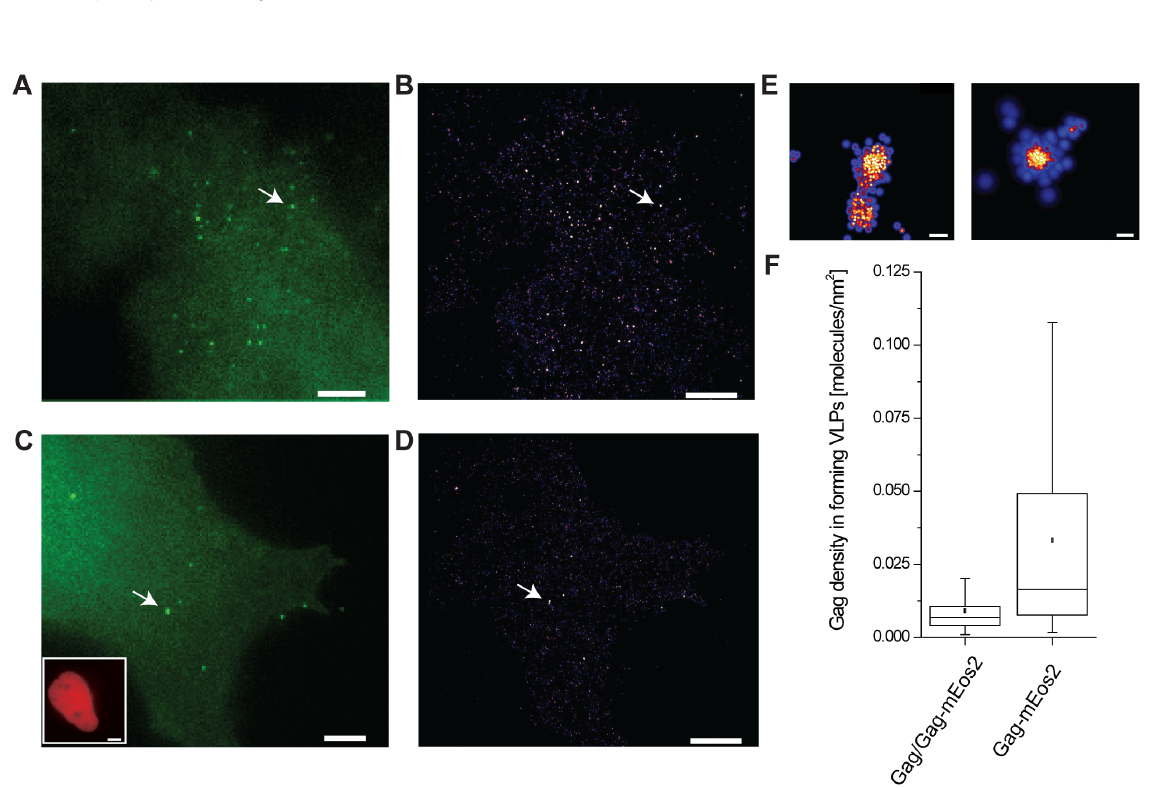
Figure 5. Unlabeled and labeled Gag protein incorporation into forming VLPs. ( A ) Diffraction limited image and ( B ) corresponding super-resolution image of a Cos7 cell expressing Gag-mEos2 only. ( C ) Diffraction limited image and ( D ) corresponding super-resolution image of a Cos7 cell co-expressing Gag and Gag-mEos2, co-transfected at an equimolar ratio. The presence of Gag is indicated via the fluorescent reporter protein H2B-mPlum (lower left inset). Scale bars, 5 m m. ( E ) Left, zoom of indicated VLP in (B). Right, zoom of indicated VLP in (D). Scale bars, 100 nm. ( F ) Gag density in forming VLPs as determined from PALM images and molecular counting. Closed squares indicate the mean, horizontal lines within the boxes median, and boxes indicate 25 th and 75 th percentiles while vertical bars indicate 5 th and 95 th percentiles. Cells co-expressing unlabeled and labeled Gag display lower densities, indicating the presence of unlabeled Gag proteins within clusters, invisible to fluorescence